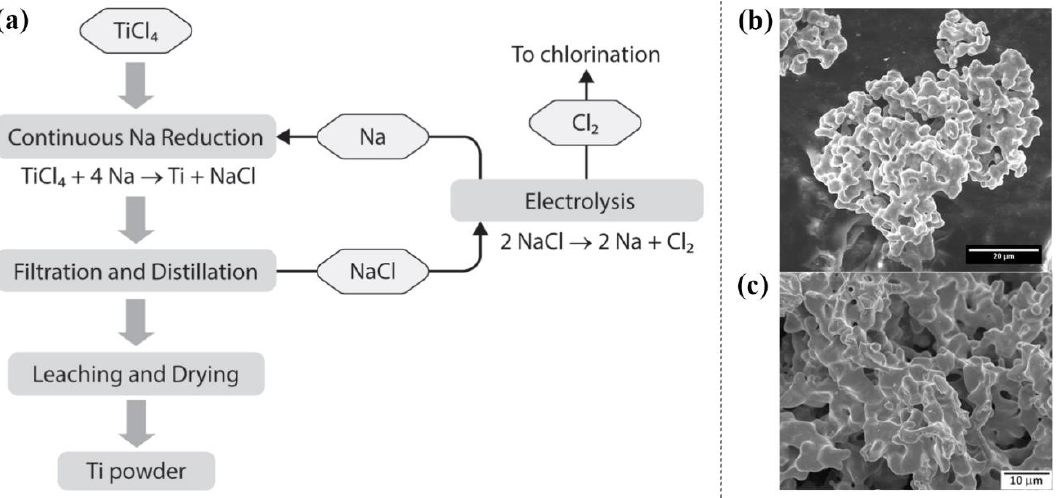
Figure 3. ( a ) Flowchart of the Armstrong process [25] (Adapted from [25], with permission from IOP Publishing, 2021); ( b ) SEM image of titanium powder produced by Armstrong process [39] (Adapted from [39], with permission from Springer, 2017); ( c ) SEM image of Ti-64 powder produced by Armstrong process [41] (Adapted from [41], with permission from Elsevier, 2011).